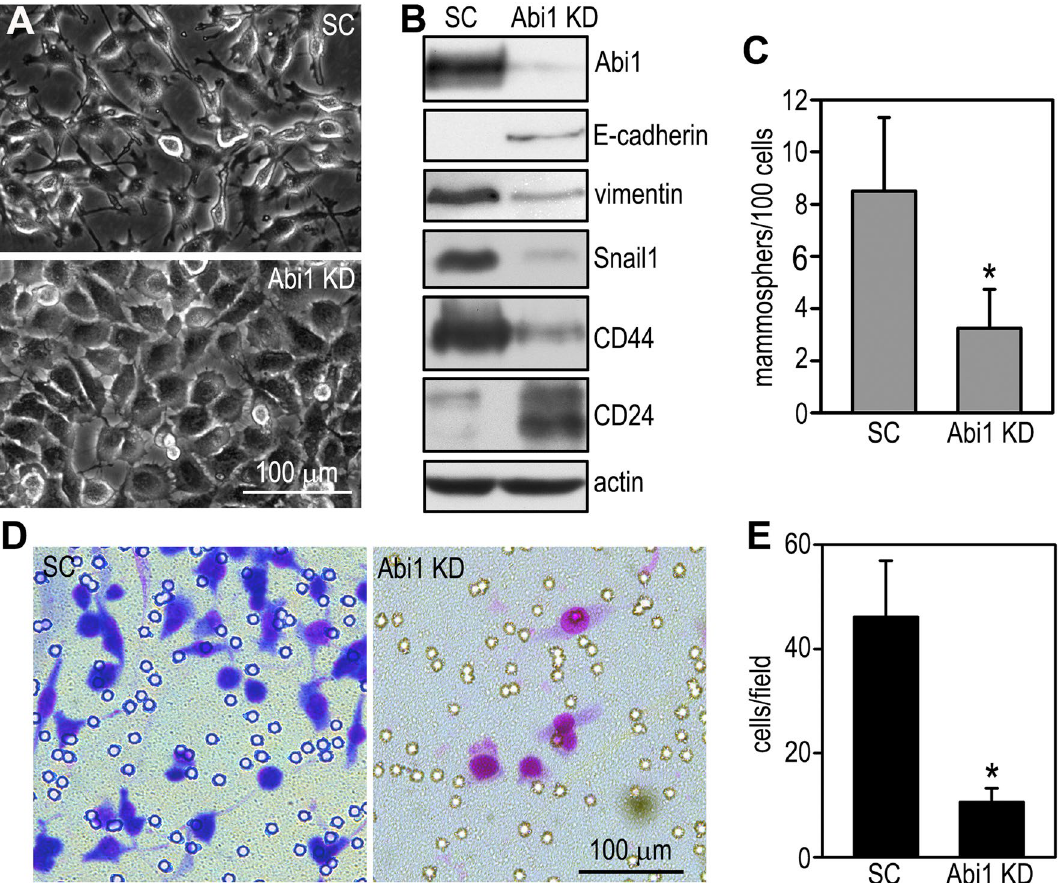
Figure 6. Depletion of Abi1 in breast cancer cells suppresses the EMT and cancer stem cell activity. ( A ) BT549 cells were stably transfected with shRNAs targeting human Abi1 (Abi1 knockdown, KD) or the scrambled control (SC). Live phase contrast micrographs of Abi1 knockdown and scrambled control BT549 cells. ( B ) The cells were analyzed by immunoblotting with actin served as a loading control. ( C ) Control and Abi1 knockdown BT549 cells were cultured in suspension for 7 days and mammosphere formation was counted. Knockdown of Abi1 reduced mammosphere formation. N = 22, * P < 0.01. ( D ) Giemsa-staining showed BT549 cells migrated to the bottom of the transwell filter in Matrigel invasion assay. ( E ) The cells migrated to the bottom of the filter were counted and plotted. N = 24, * P <